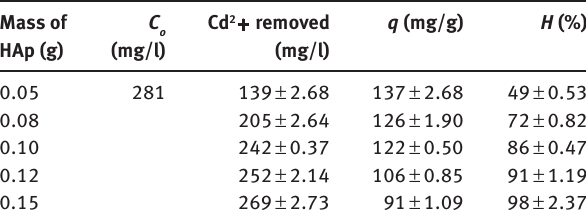
Table 5: Variation of the parameters C amount of HAp.